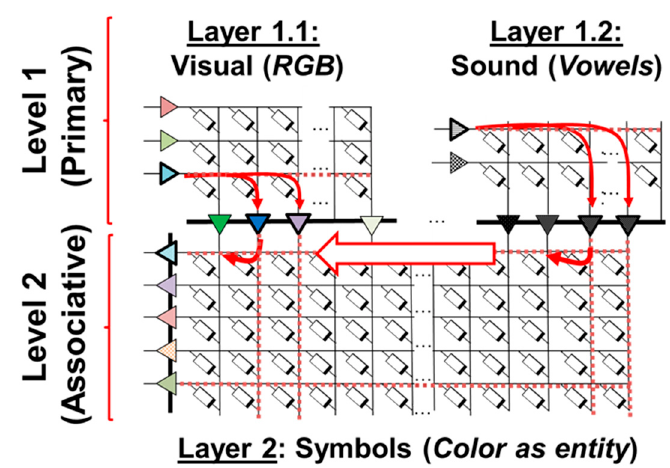
Figure 14. Basic hierarchical computing architecture where the first level (primary) is composed of two memristive synaptic layers, which pre-process the information following the unsupervised algorithm introduced in this work. The output of these layers is fed as the input data of a layer within a higher-order of computation level, where associative learning takes place.